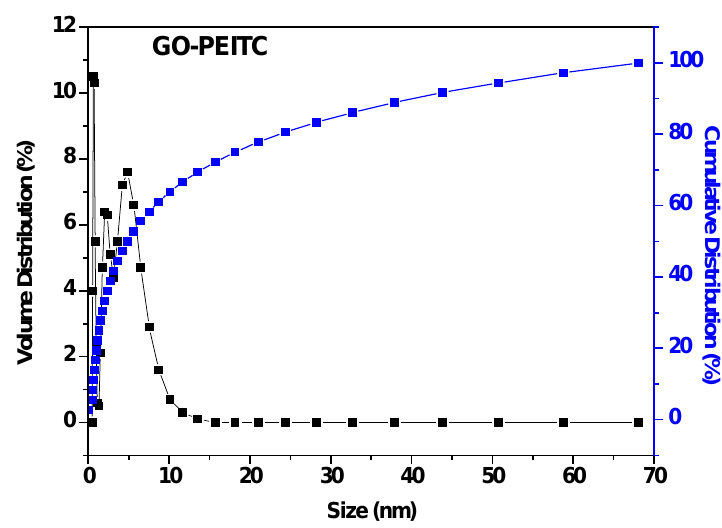
Figure 6. Hydrodynamic size of the nanocomposite GO-PEITC determined by DLS.